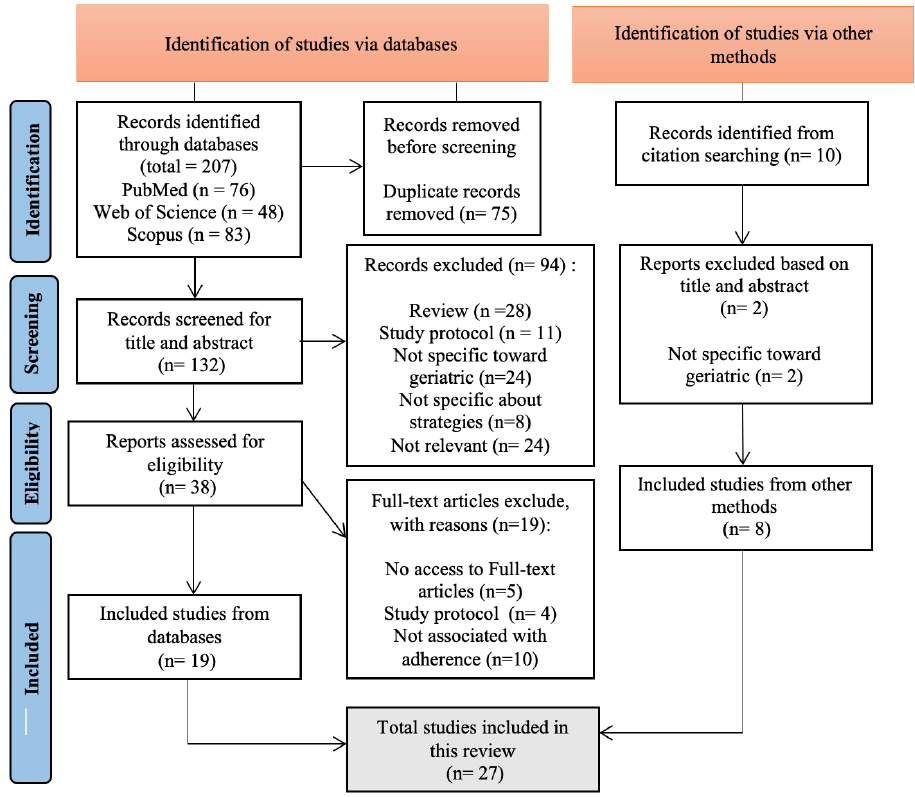
Figure 1. PRISMA diagram of this review.